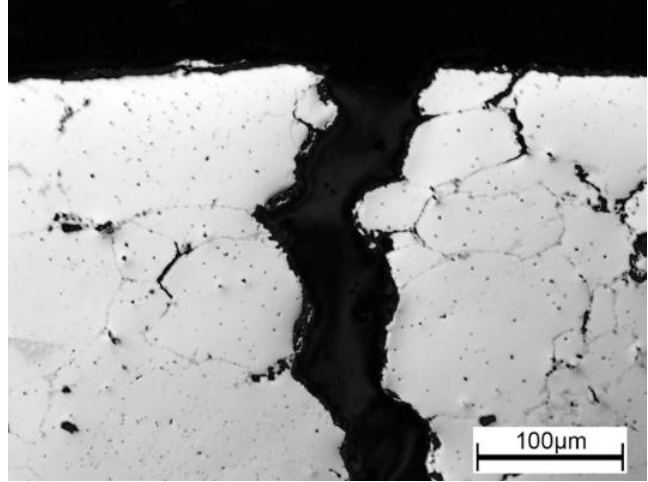
Figure 5. Typical appearance of cracks present at the circumference of select products after TMP. Sample 2C processed at 500 °C and 5 s −1 . TMP direction was normal to the plane of the image.